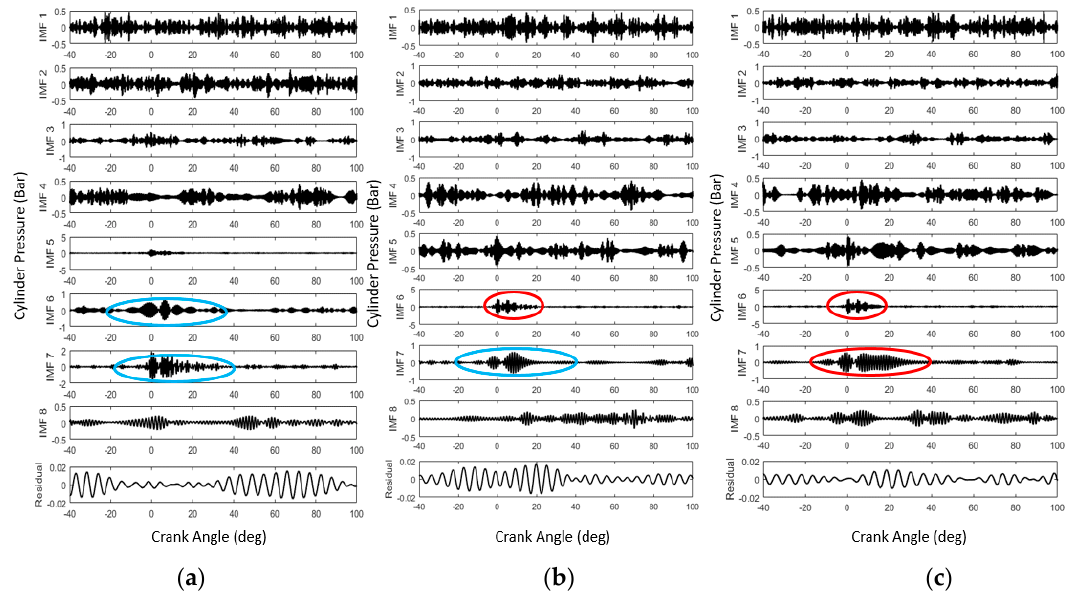
Figure 11. Intrinsic mode functions (IMFs) components of in-cylinder pressure by cyclic average TVF-EMD with different cyclic number in crank angle domain: ( a ) 10; ( b ) 50; ( c ) 70 cycles.